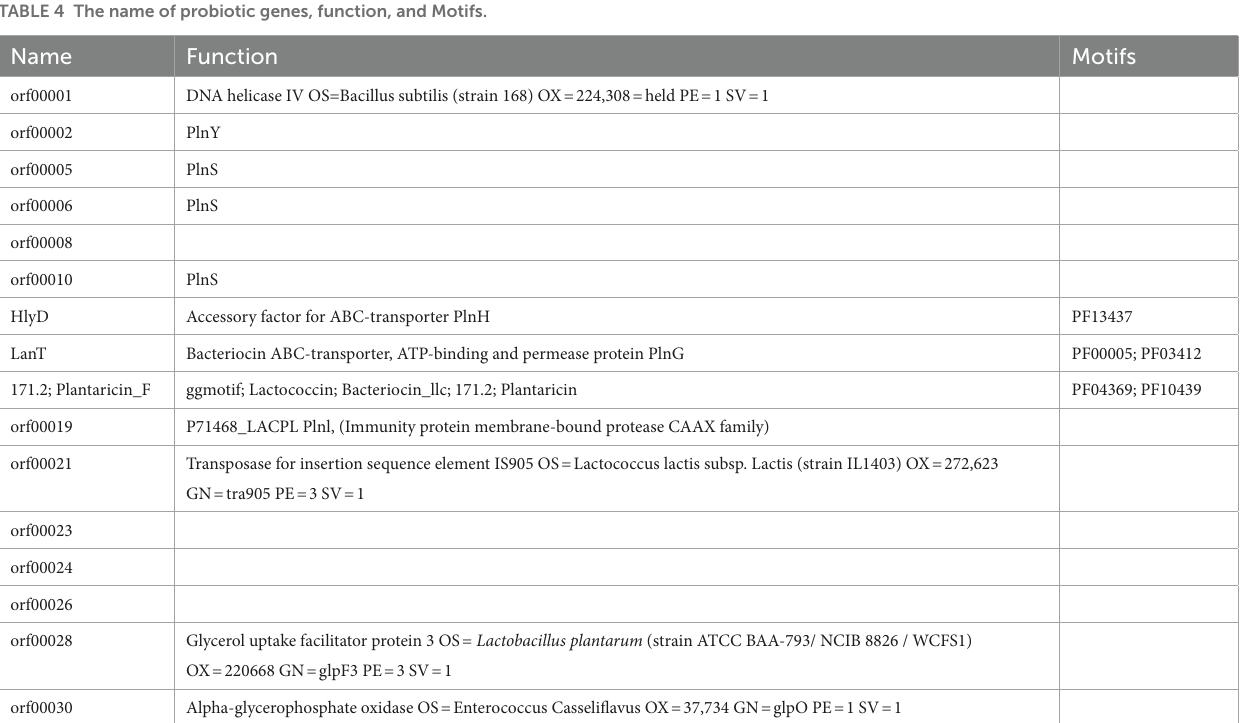
TABLE 4 The name of probiotic genes, function, and